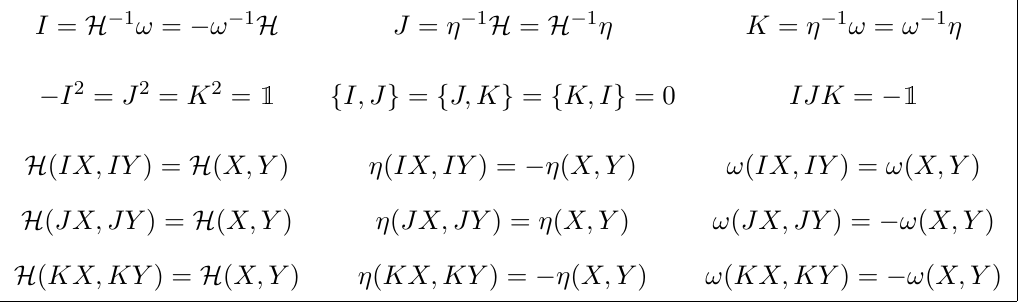
Table 1 . Summary of structures in Born geometry. Here f ; g is the